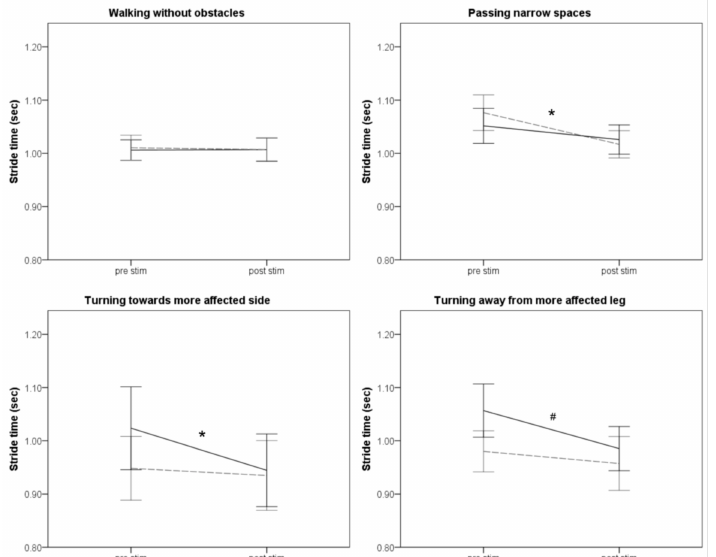
Figure 1. The results for stride time on the leg on the body side more affected by Parkinson’s disease (PD) symptoms are shown (mean ± 95% confidence interval). The results from the visit when intermittent theta burst stimulation (iTBS) was applied are shown as solid black line, those from the visit when sham was applied as dashed gray line. The asterisk (*) indicates statistically significant task-repetition × stimulation interactions (i.e., iTBS specific effects; p < 0.05), the hash (#) borderline significant interactions ( p <